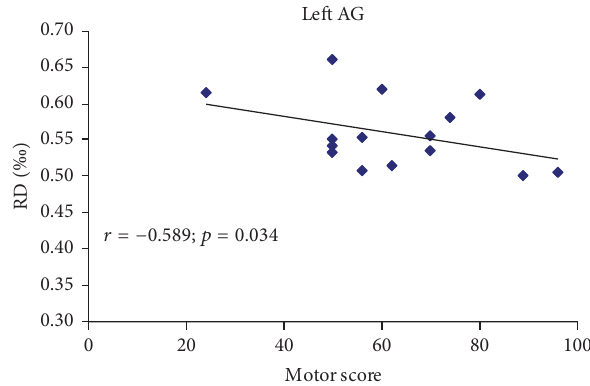
Figure 3: The correlation between diffusion metrics and clinical scores in SCI patients. Pearson correlation showed negative asso- ciation between the RD of left AG and motor score of ASIA. ( 𝑟 = −0.589 , 𝑝 = 0.034 ; uncorrected). RD: radial diffusivity, AG: angular gyrus, ASIA: American Spinal Injury Association, SCI: spinal cord